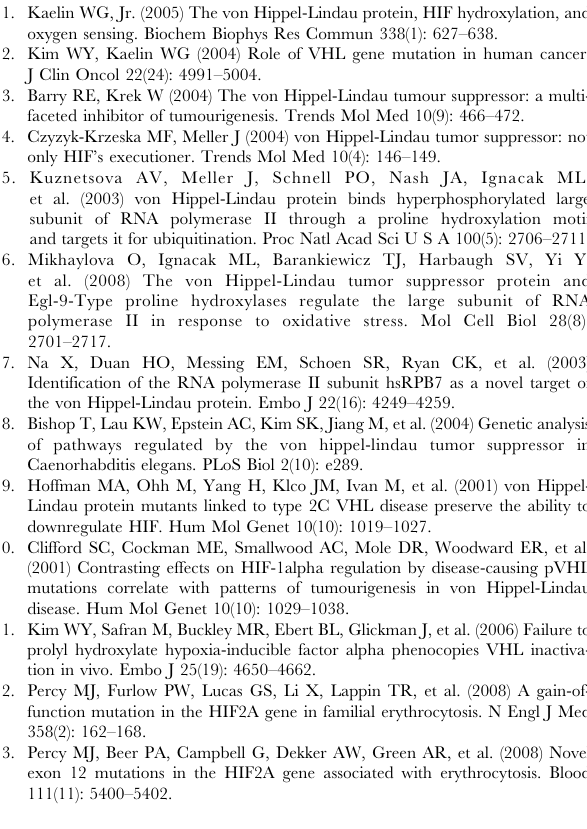
Table S3 List of proteins coimmunoprecipitated with p160. The list of proteins that displayed more than 2-fold enrichment in FLAG-p160 immunoprecipitate is available as ‘list of proteins coimmunoprecipitated with p160.xls’ file. This dataset contains proteins with ProteinProphet probability score $ 0.5. Protein abundance ratios were calculated using ASAPRatio software tool. Abundance ratio of 999 denotes that the protein displayed obvious enrichment in the FLAG-p160 immunoprecip- itate, but was difficult to quantify. The description of each column in this data file is as follows: A: ProteinProphet probability score B: Protein abundance ratio (FLAG-p160/FLAG-vector) C: